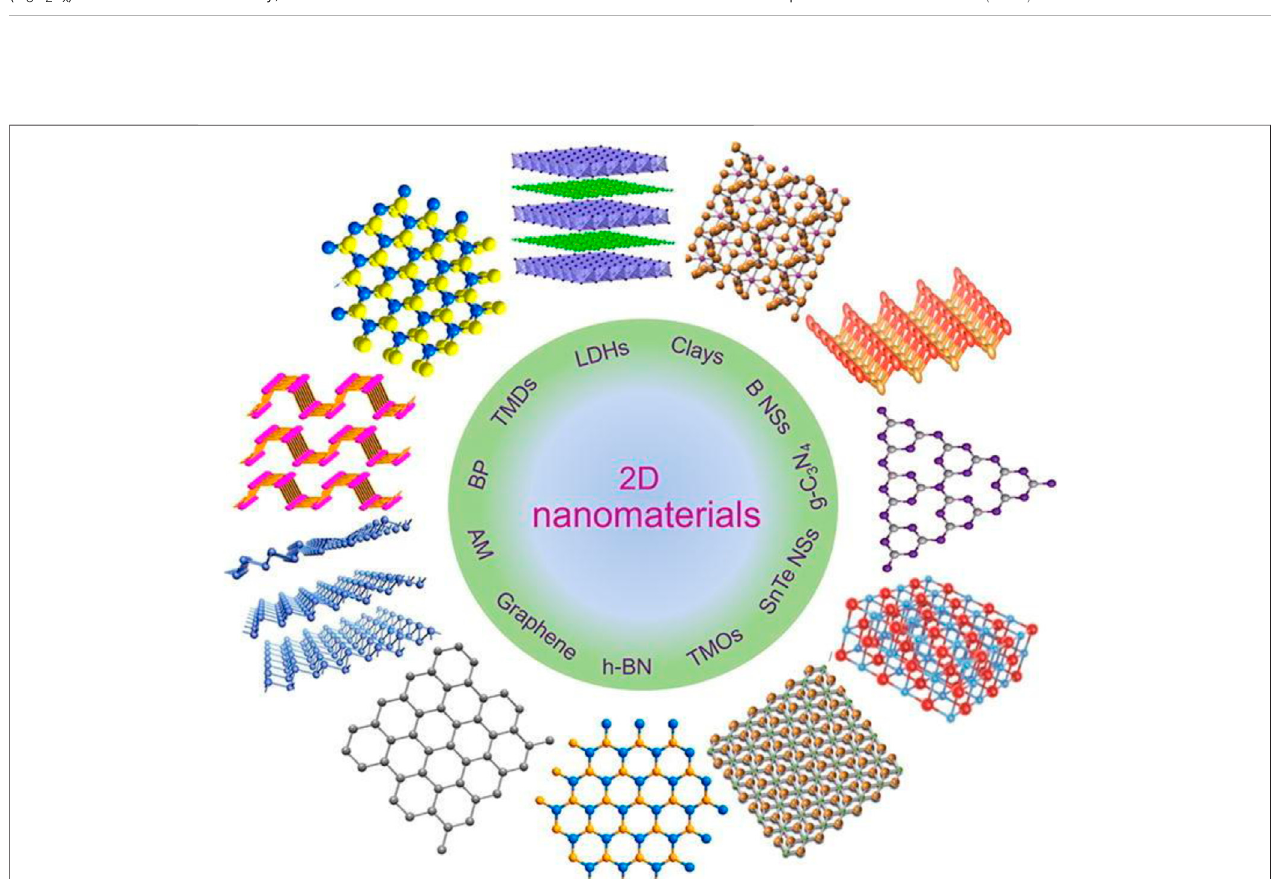
Frontiers in Environmental Science |